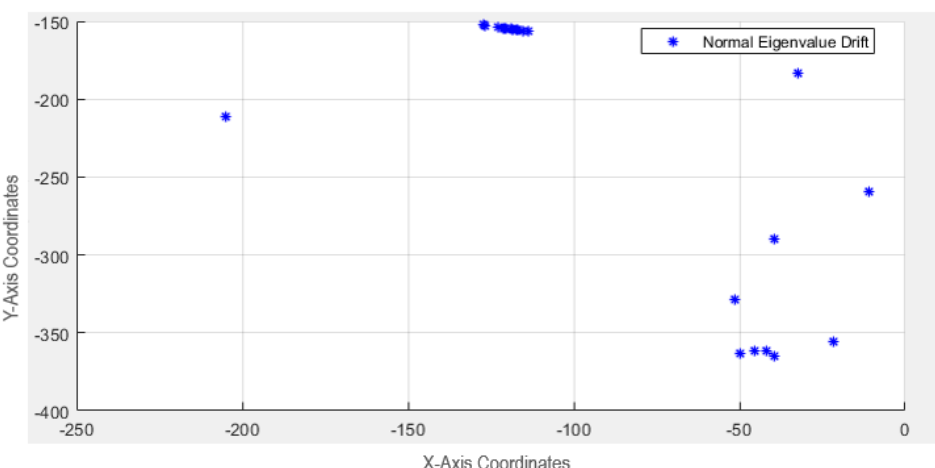
Figure 18. Baseline eigenvalues. Clusters are generated using k -means clustering and the EDC, as seen in Figure